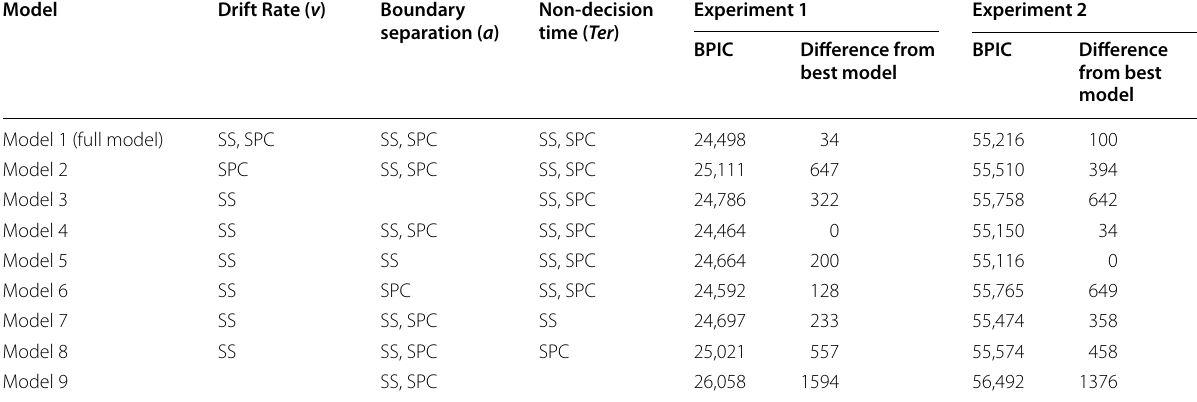
Table indicates parameter estimates that were allowed to vary for each model SS set size, SPC spring pressure condition